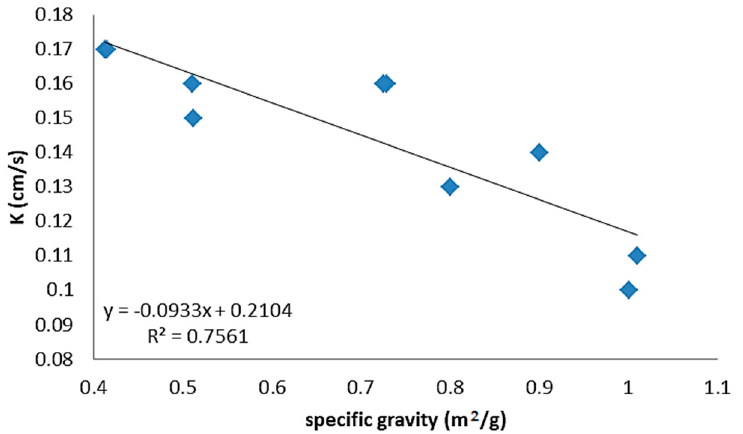
Figure 10. Specific gravity of the tested aggregates vs. the permeability coefficient (k) of the produced concrete specimens.